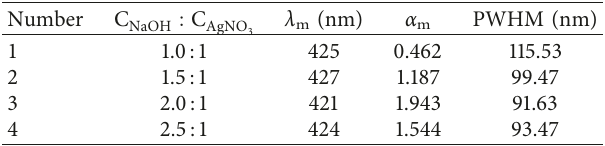
Table 1: Test results of AgNPs synthesized under different NaOH